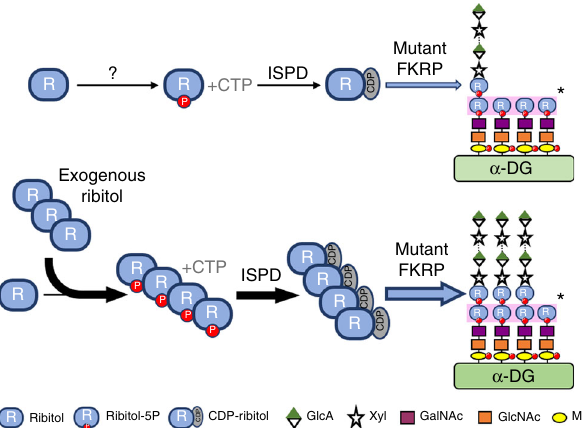
Fig. 8 Model for ribitol-induced functional glycosylation of α -DG in FKRP mutant cells. “ ? ” mechanism(s) is not understood, “ * ” fi rst ribitol-5P on the Core M3 of α -DG is transferred by fukutin using also CDP-ribitol as